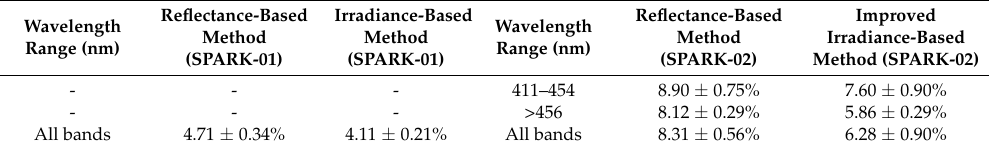
Table 7. Average relative differences for various wavelength